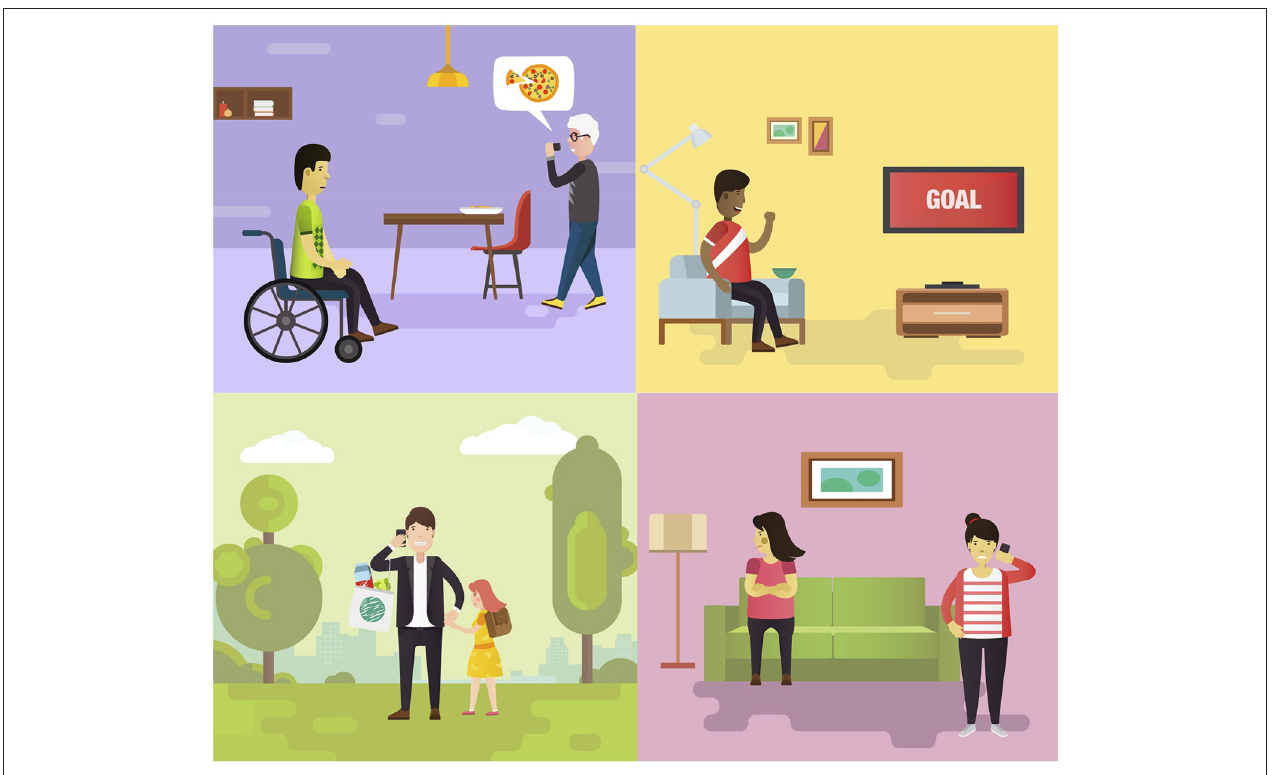
FIGURE 5 | Examples of diverse GMT +